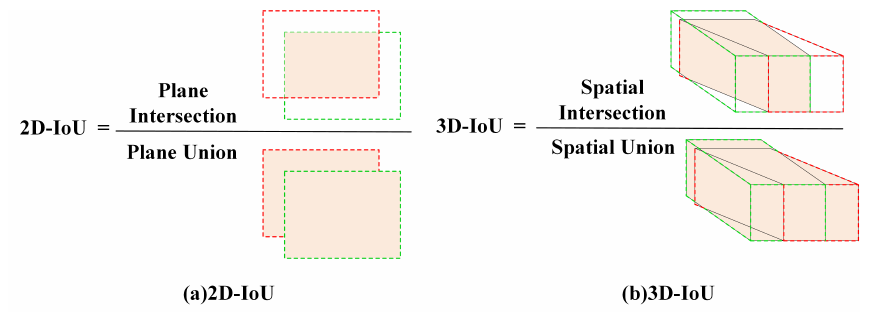
Figure 5. IoU calculation formula and schematic